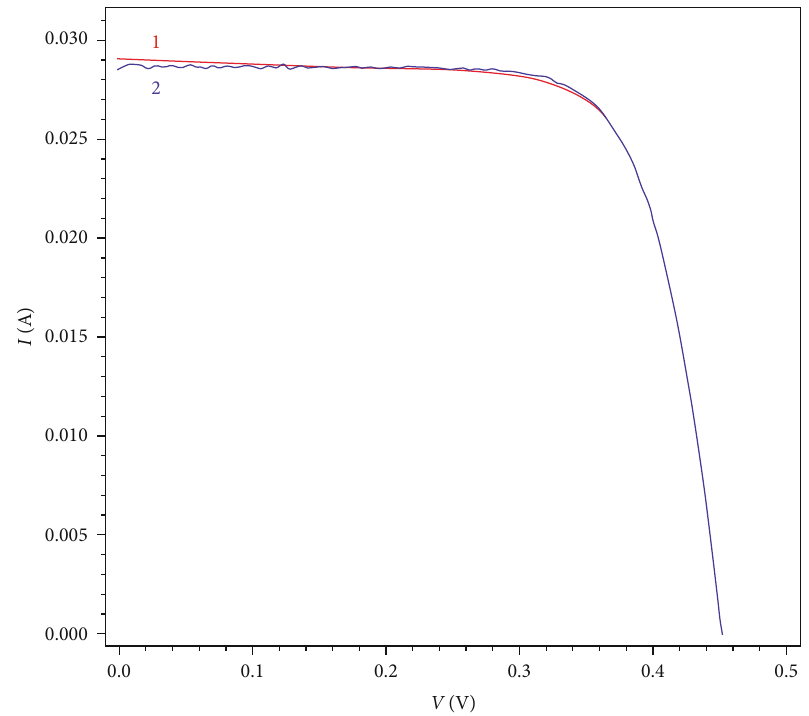
: 0291A (2) and overlapping of curves (1). ph = 0